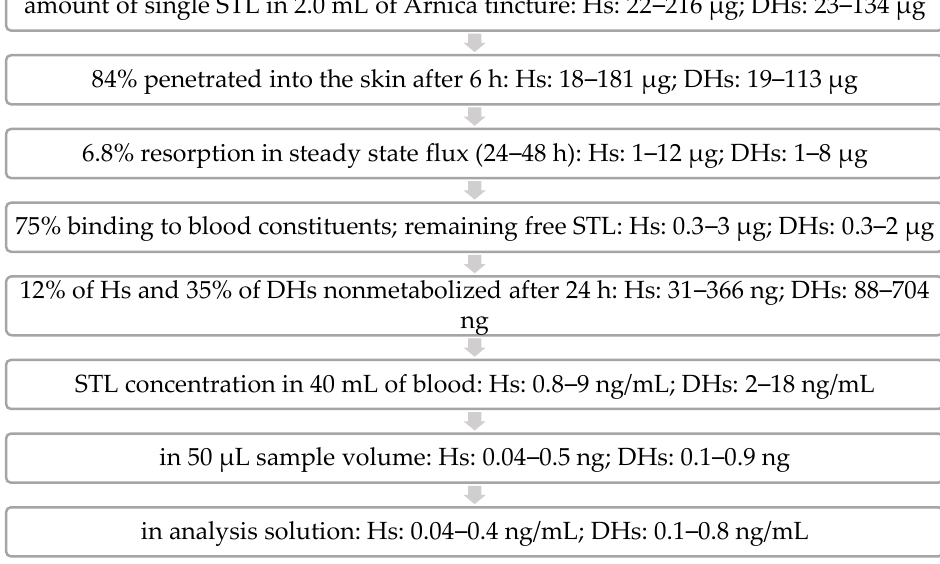
Figure 3. Scheme of theoretical STL concentration in plasma of rats in PK studies.